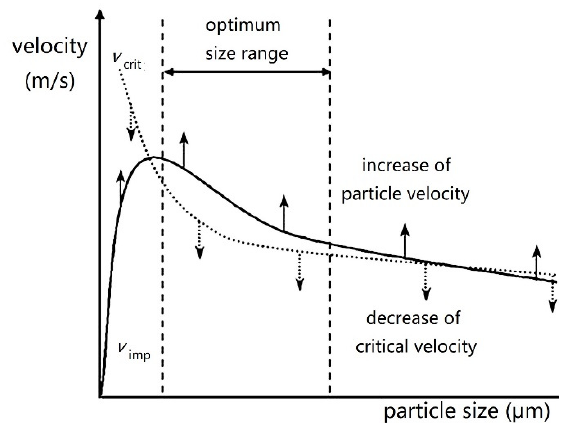
Figure 16. Optimization of particles size range according to the critical and impact velocities. Reprinted with permission from [71] Copyright 2021 Springer .